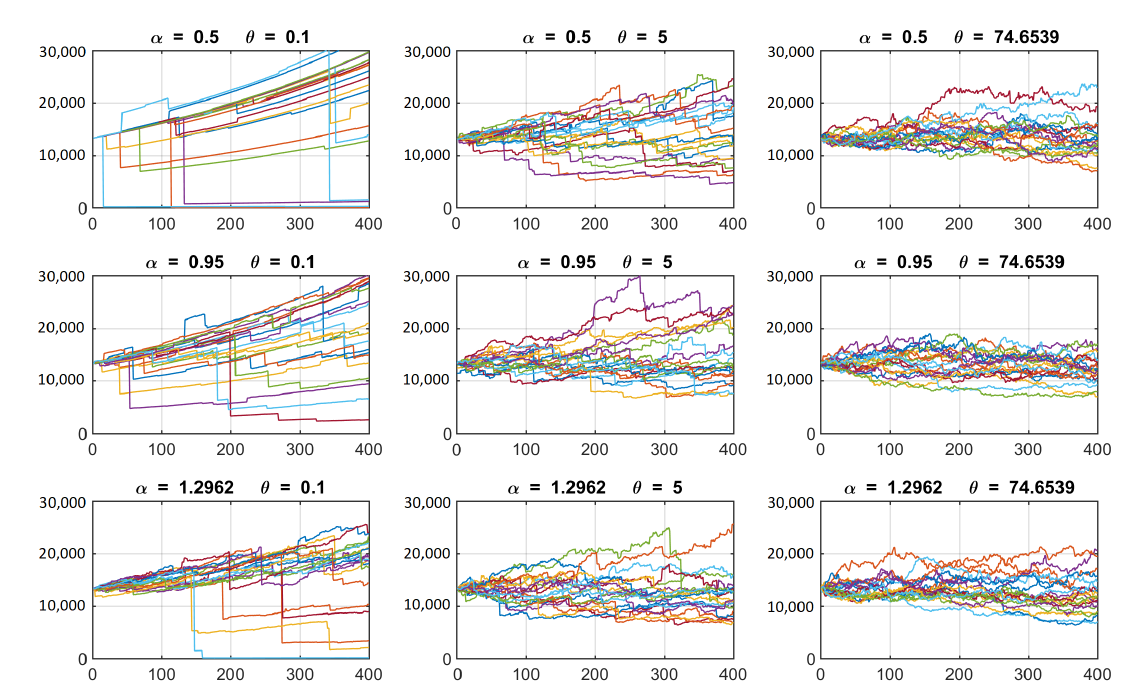
Figure 3. Simulated NTS price paths of V / F for varying α and θ . Remaining parameters were held fixed (see Table